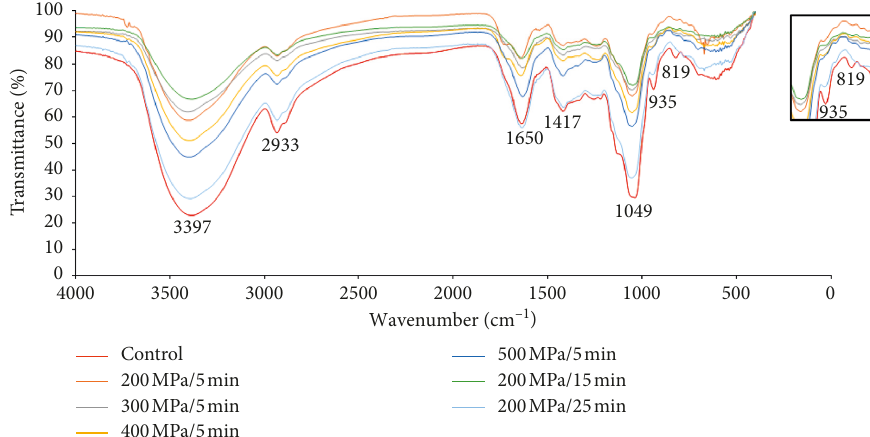
Figure 3: FT-IR spectra of black garlic-extracted